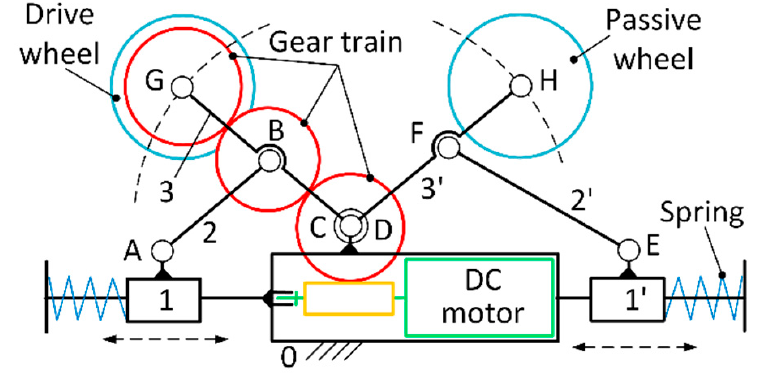
Figure 8. Adapting mechanism with 2DOF.